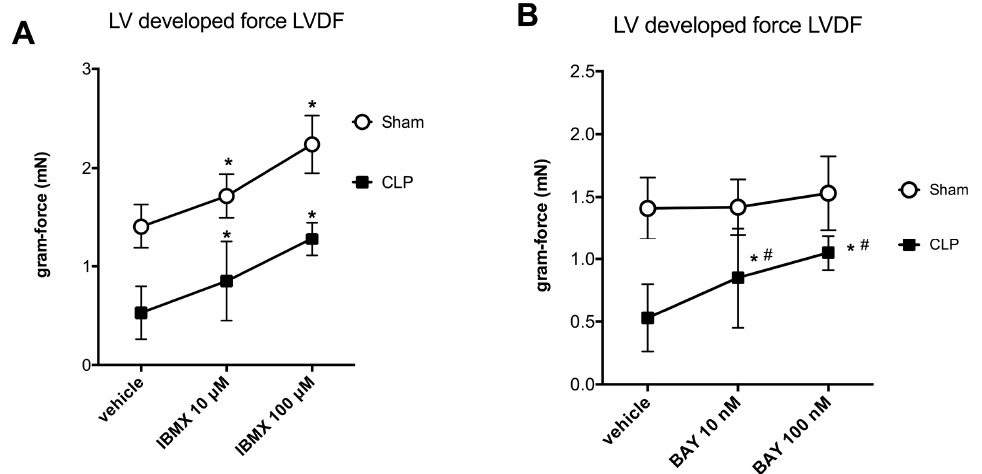
Figure 7. Effects of perfusion of phophosdiesterase (PDE) inhibitors; IBMX ( A ); or BAY 60-7550 ( B ) on left ventricle developed force (LVDF; gram.force in mN) in isolated hearts of control and CLP sepsis. See Materials and Methods for details. Data are mean ± SD. Results were analyzed with two-way ANOVA (dose response—group mice) and Bonferroni’s multiple comparison post hoc adjustment ( n = 8 per group; * indicates p < 0.05 versus vehicle. # indicates adjusted p < 0.01 versus control group).